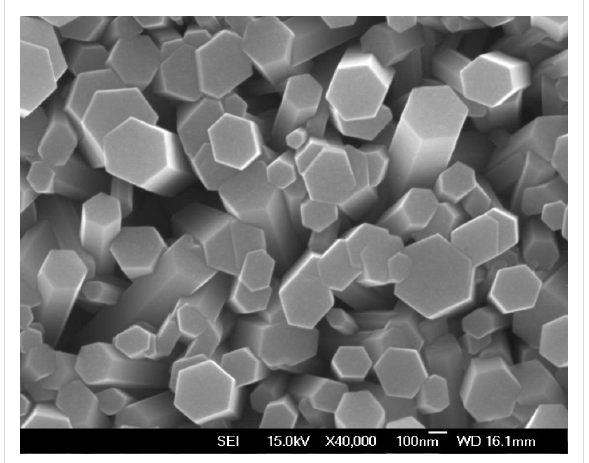
Figure 2: Top view of ZnO nanorod arrays grown on a ZnO-seeded ITO substrate at 90 °C for 10